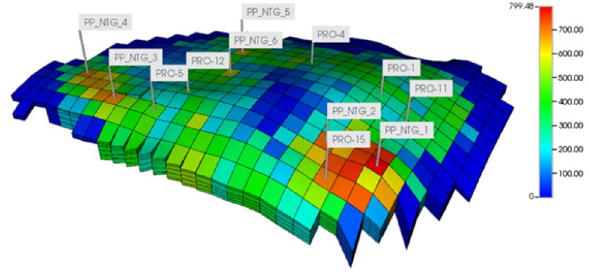
Fig. 7 PP_NTG_1 to PP_NTG_6 placed at best PP C and PP